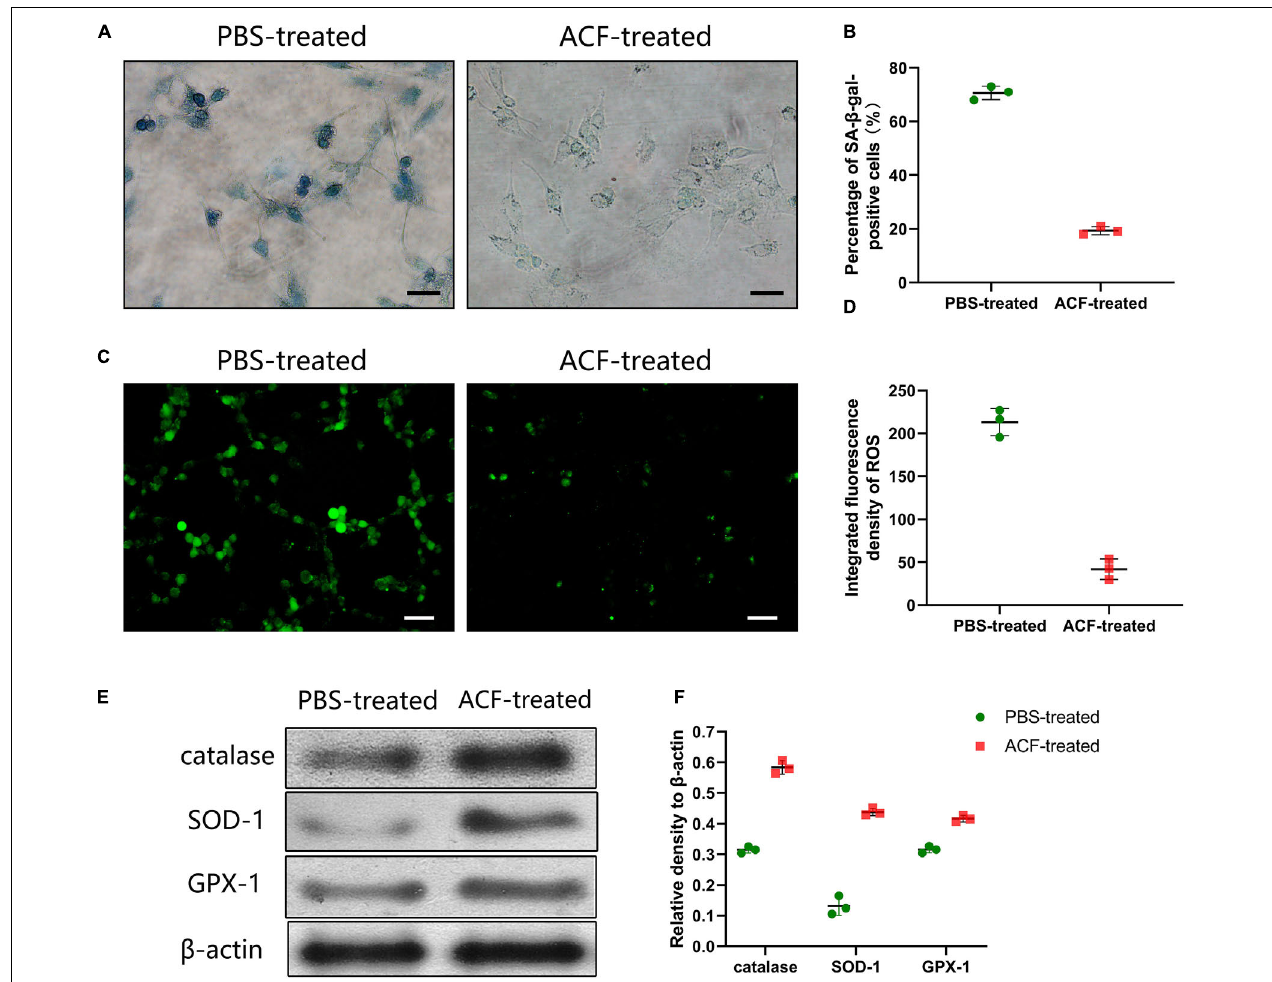
FIGURE 8 | Effects evaluation of ACF with UVA-induced L929 cells in vitro . (A) The expression level of SA- β -gal-positive cells of ACF-treated and PBS-treated groups. (B) Semi-quantification analysis demonstrated that the number of SA- β -gal-positive cells was significantly higher in the PBS-treated group than in the ACF-treated group. P = 7.159E-06, F = 0.538. Scale bar = 150 µ m. (C) ROS production evaluated by dihydroethidium staining of three groups. (D) Semi-quantitative analysis showed a higher level of ROS was observed in the PBS-treated group than in the ACF-treated group. P = 1.194E-04, F =